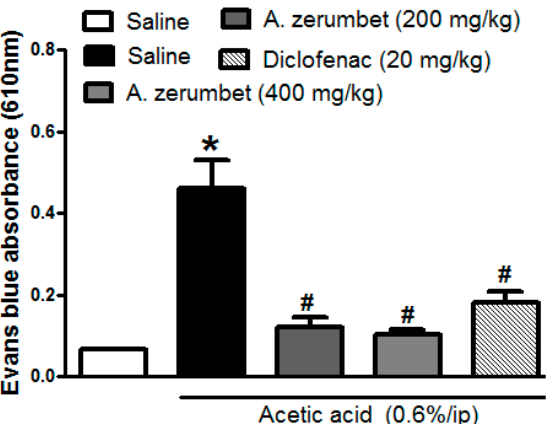
Figure 7. Effect of treatment with the extract (200 and 400 mg/kg, p.o.) on acetic acid-induced vascular permeability. The indicator of inflammation is the amount of Evans blue dye in the abdominal cavity. The values are expressed as the means ± S.E.M. (n = 5–7). * p < 0.001 compared to saline group. # p < 0.001 compared to control (acetic acid only treated group).